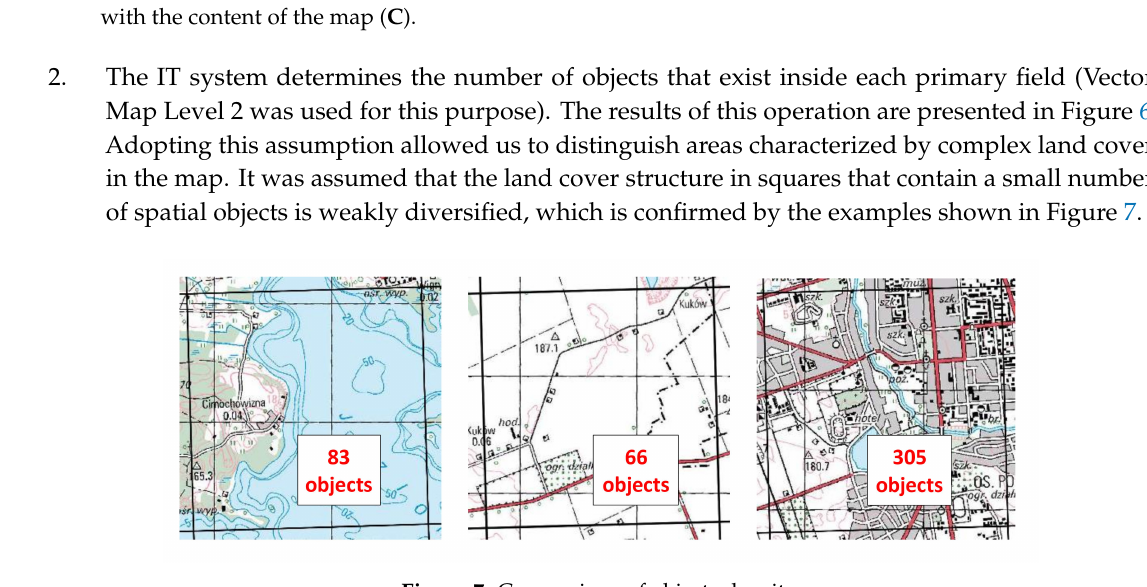
Figure 7. Comparison of objects